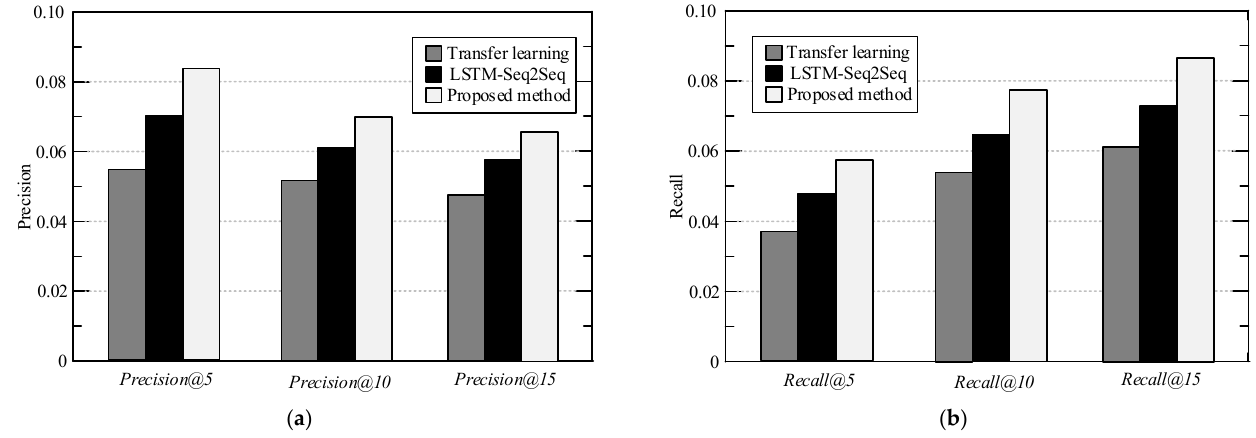
Figure 4. Experimental comparison results on loc-Brightkite data set ( a ) precision ( b ) recall.